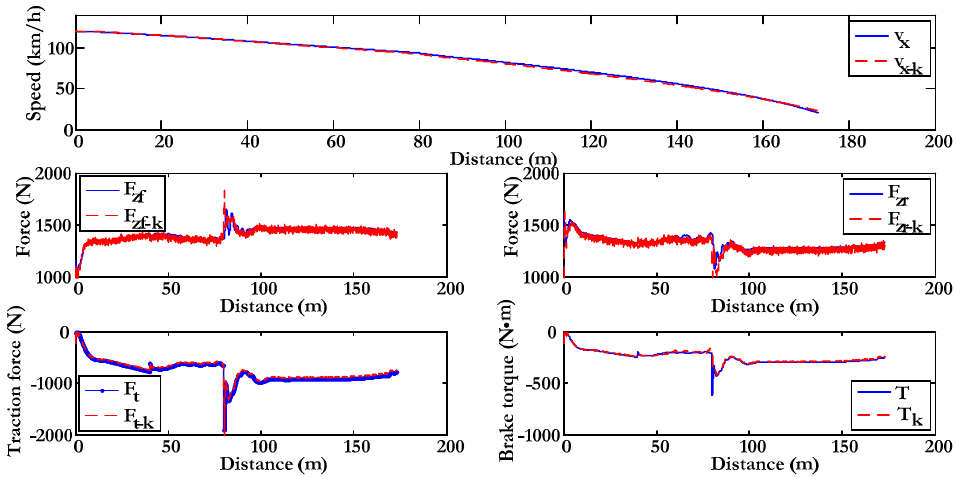
Figure 6. Estimation of speed, tractor effort and vertical forces.